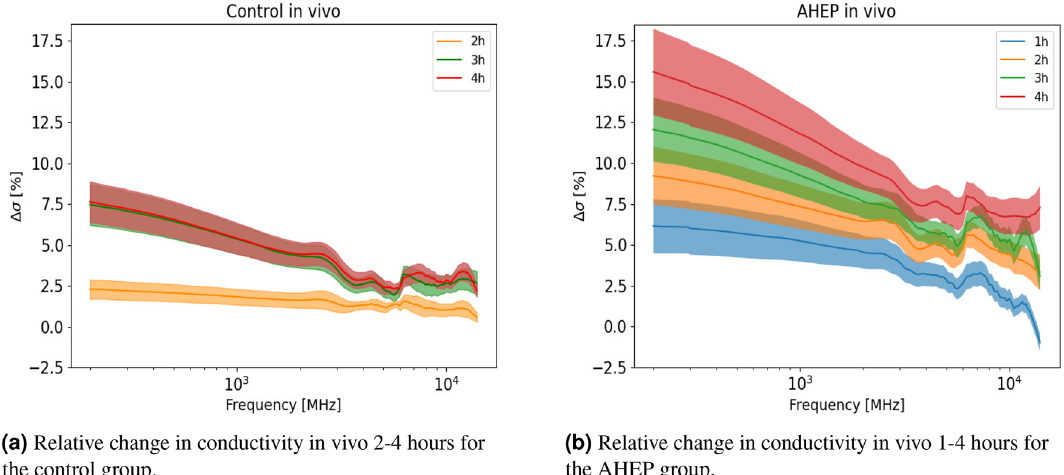
Figure 1. Figure shows the relative change (mean and standard error) in conductivity monitored in vivo for both control and AHEP livers calculated with Eq. (2). One hour data is not shown in ( a ) as it is used as